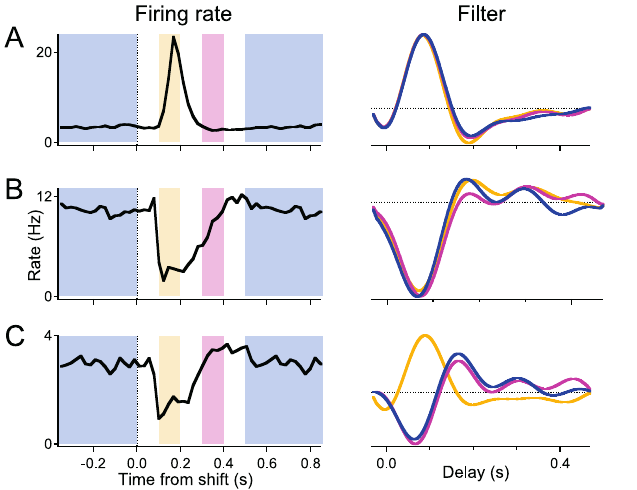
Figure 2. Some Retinal Ganglion Cells Turn from Off-Center to On-Center following a Peripheral Shift Response modulation by the peripheral grating shift is illustrated for three sample ganglion cells: an On cell (A), an Off cell (B), and a polarity- reversing cell (C). Left: changes in firing rate induced by the peripheral shift, displayed as in Figure 1D, bottom. Here and in subsequent figures, the grating shifts of both polarities were averaged. Note that a shift occurred every 0.9 s, so the first and last 0.4 s of these plots are identical. Right: linear filter computed with respect to the flickering spot stimulus in three time periods: the baseline in the 0.4 s preceding the peripheral shift, 0.1–0.2 s after the shift, and 0.3–0.4 s after the shift. The color of the curves corresponds to the time periods on the